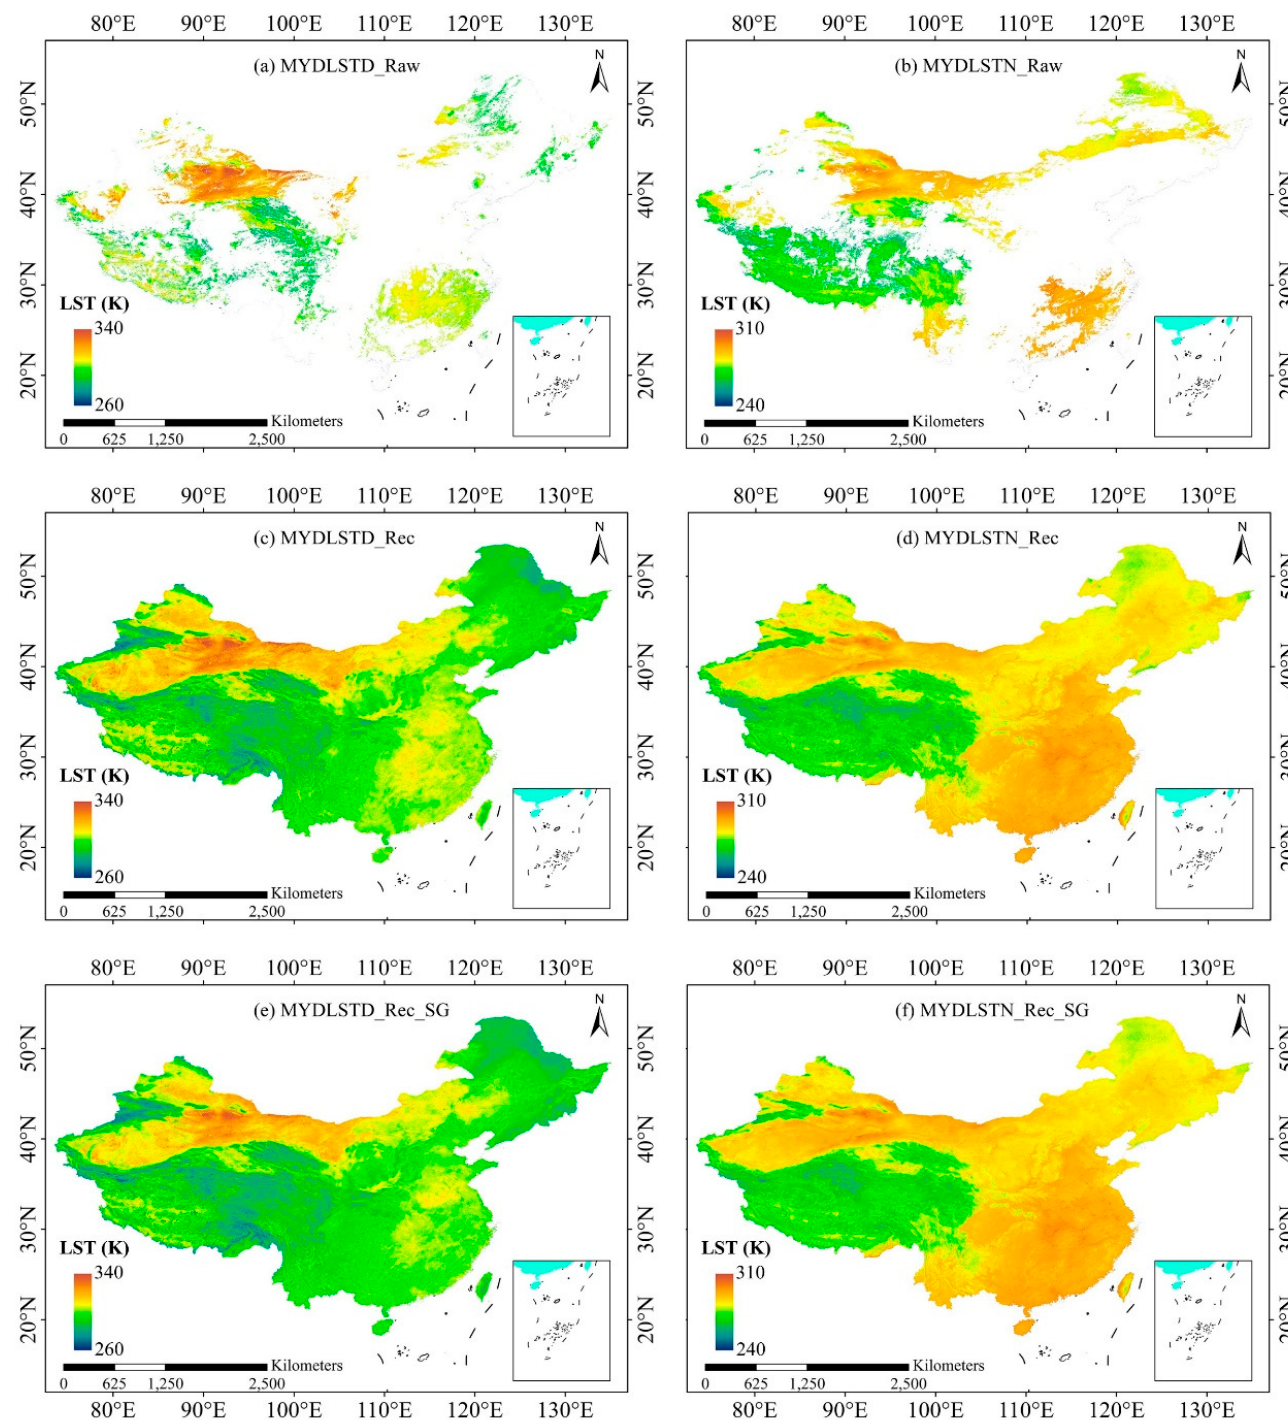
Figure 4. Comparison of ( a ) MYDLSTD_Raw; ( b ) MYDLSTN_Raw; ( c ) MYDLSTD_Rec; ( d ) MYDLSTN_Rec; ( e ) MYDLSTD_SGRec, and ( f ) MYDLSTN_SGRec on the 167th day of 2018.